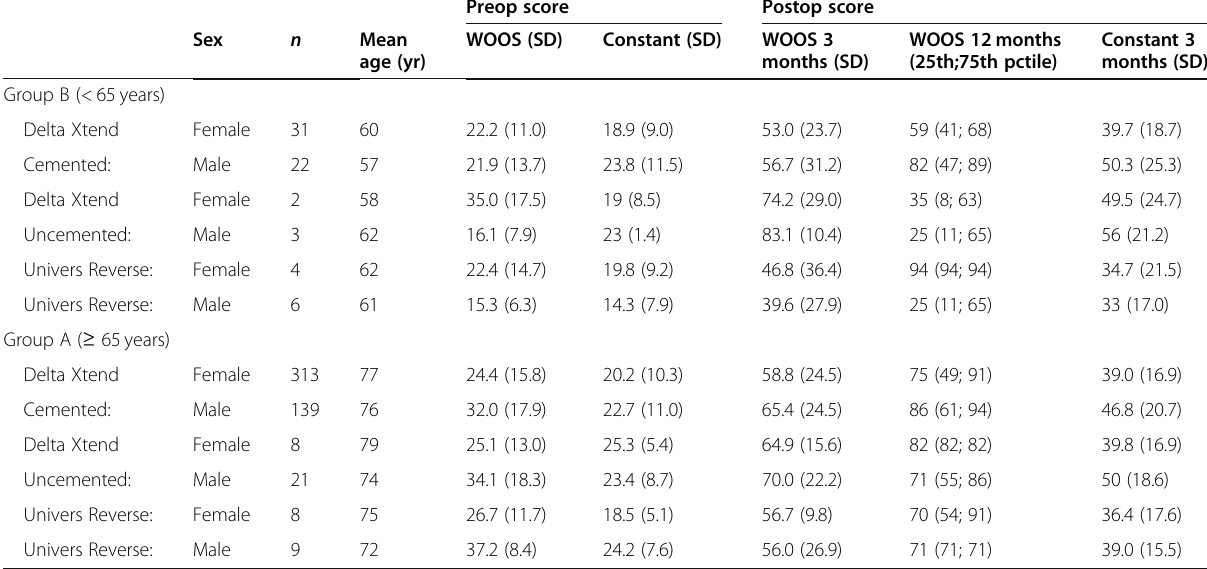
Table 1 Demographics of the patients receiving a reverse shoulder arthroplasty from 2014 to 2020 Preop